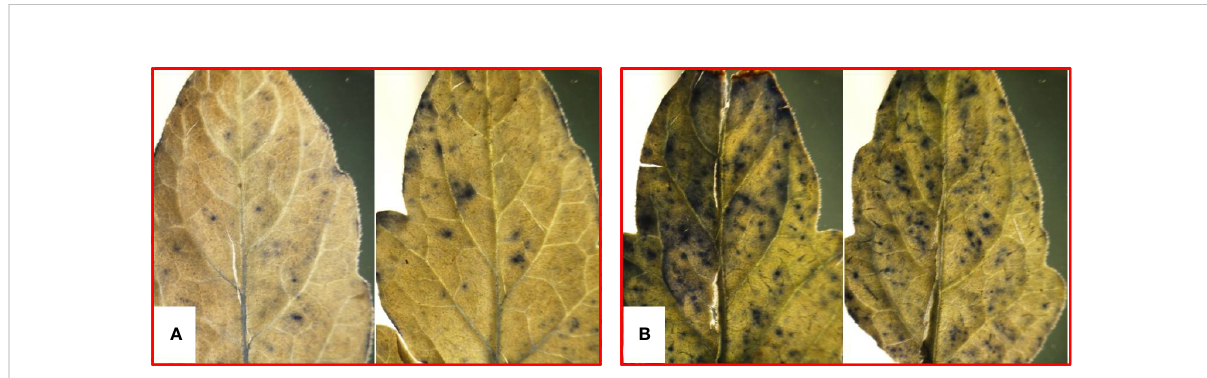
FIGURE 1 ROS accumulation in tomato leaves due to pathogenic stress as appeared from staining with nitroblue tetrazolium: (A) control and (B) pathogen